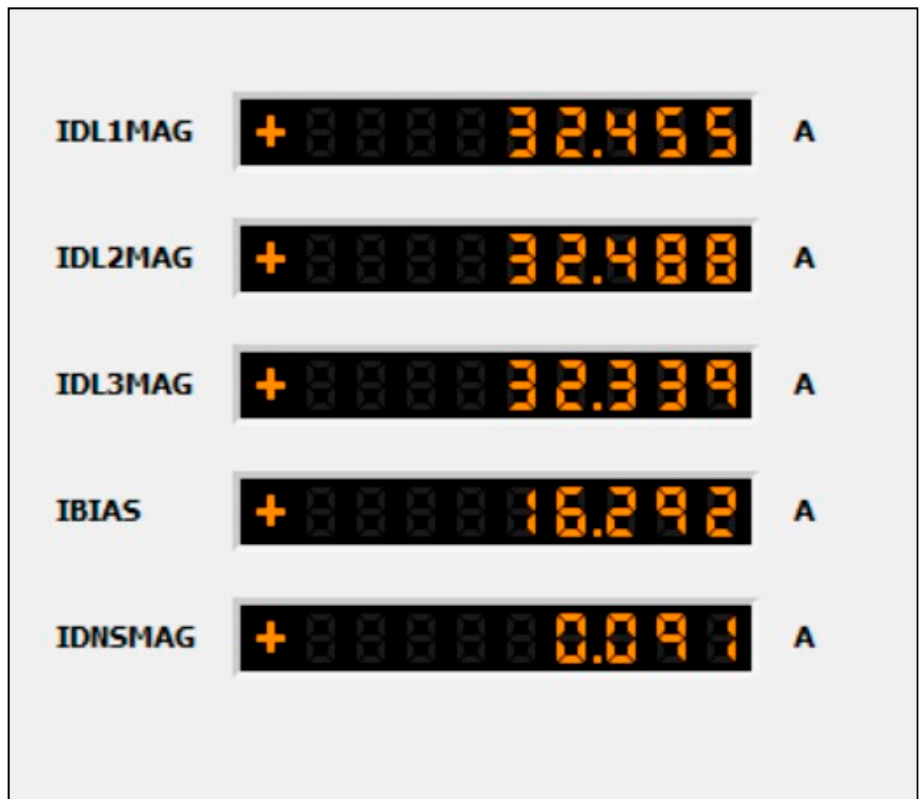
Figure 9. Measured values for differential ( I 0 ) and biased ( I b ) currents by the relay RET670 [16].